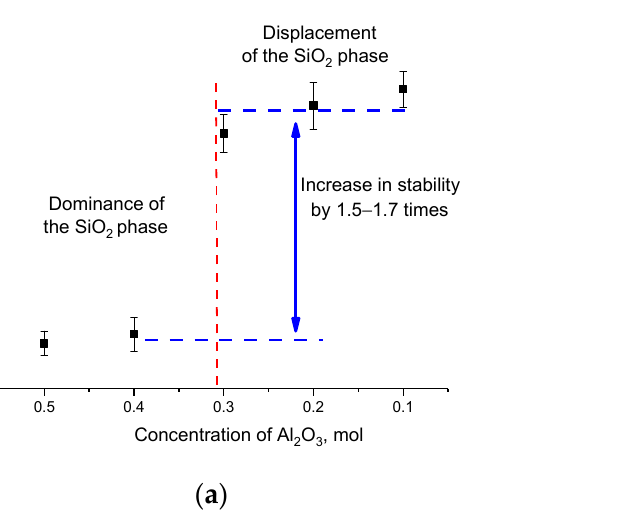
Figure 12. ( a ) Dependence of the change in the strength characteristics of (1 − x)Si 3 N 4 - xAl 2 O 3 ce- ramics with variation of the components; ( b ) Dependence of the change in hardening characteris- tics on the criterion of metallization of ceramics.